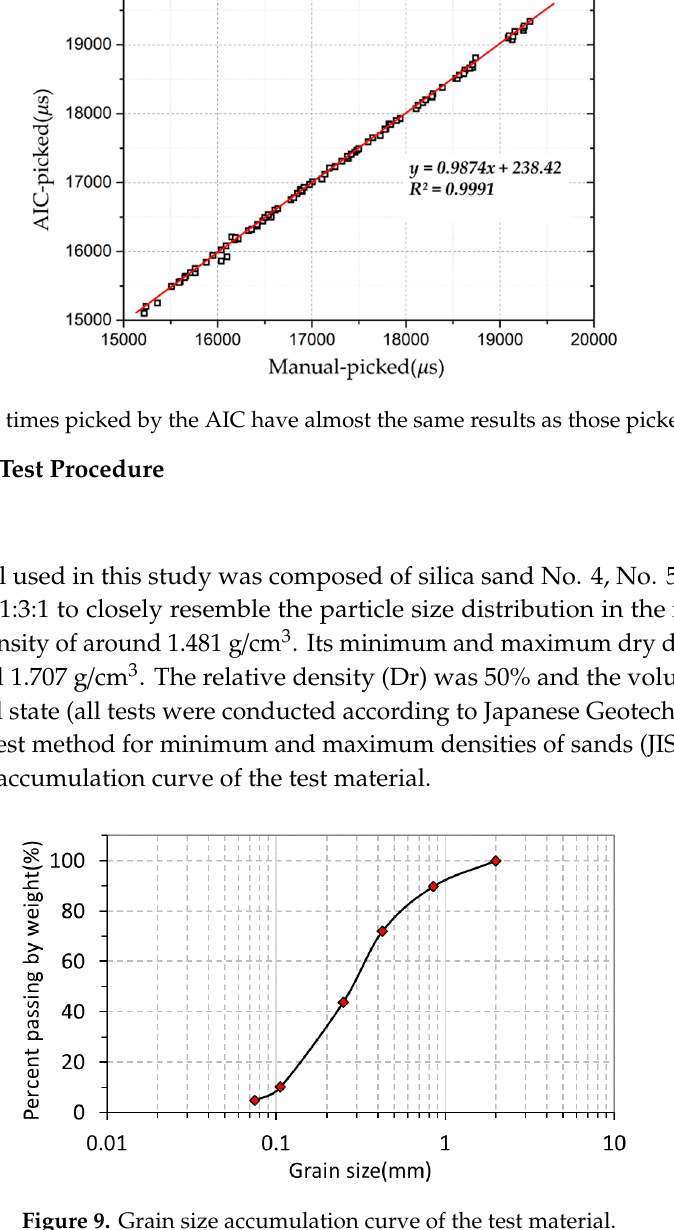
Figure 9. Grain size accumulation curve of the test material.